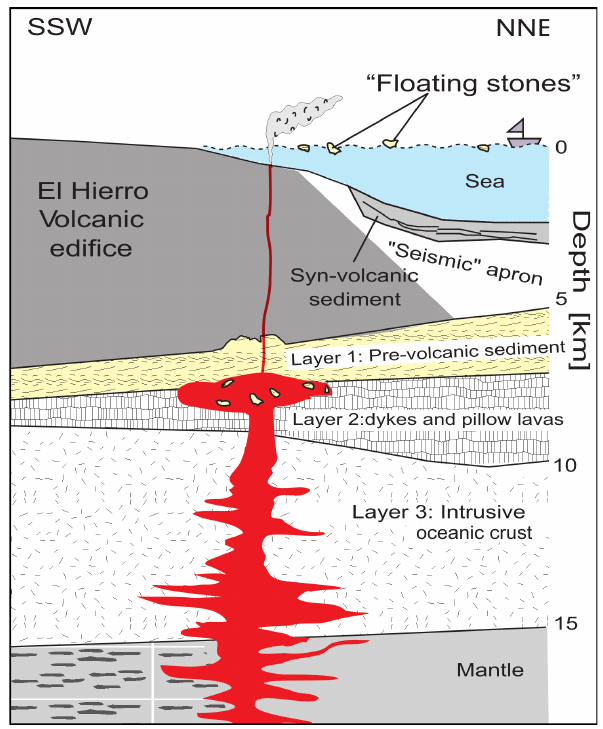
Fig. 6. Sketch showing the internal structure of El Hierro Island. Ascending magma is interacting with the pre-volcanic sedimentary rocks, and we suggest that the early floating stones found at El Hi- erro are the products of magma-sediment interaction beneath the volcano. Pre-island sedimentary material was carried to the ocean floor during magma ascent and eruption and melted and vesiculated while immersed in magma to develop a pumice-like texture (“xeno- pumice”). Once erupted onto the ocean floor, these xeno-pumices separated from the host lava and floated on the sea surface due to their high vesicularity (i.e. their low